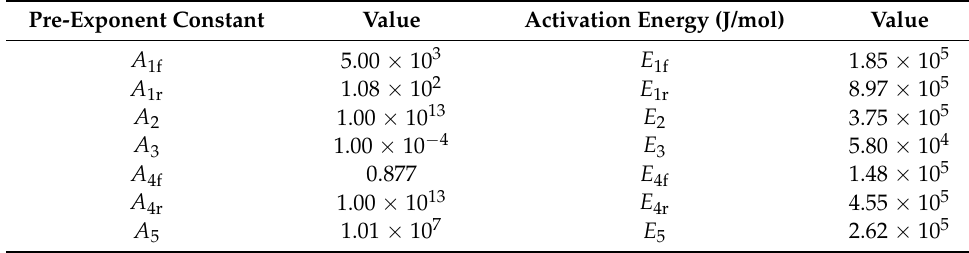
Table 1. Parameters in Boudouard gasification